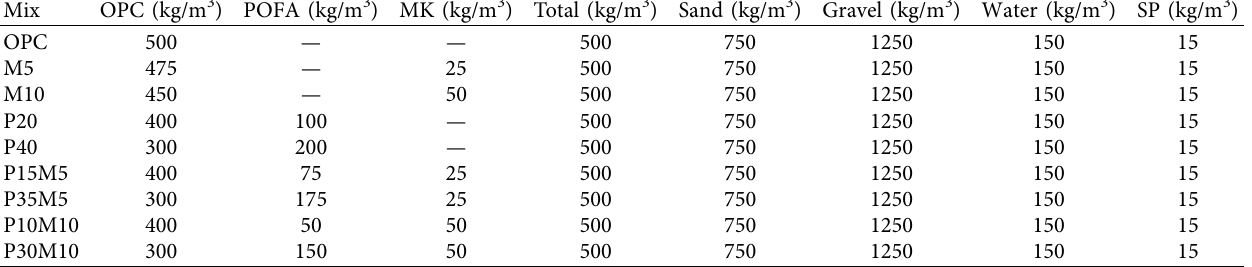
Table 3: Mix design proportion.